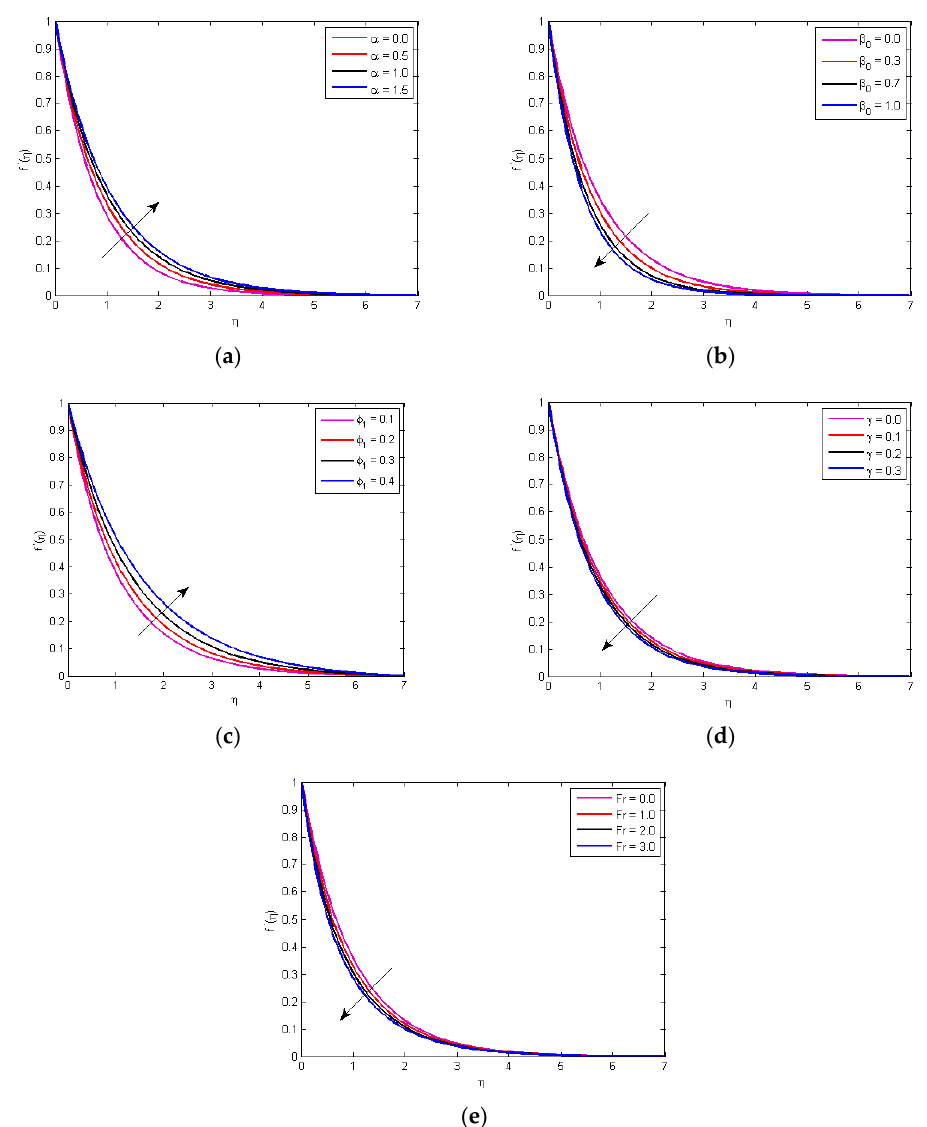
β φ α γ , ( b ) is 0 , ( c ) is 1 , ( d ) is , ( ) θ η against relevant flow parameters, such as β γ , curvature parameter , Prandtl number 0